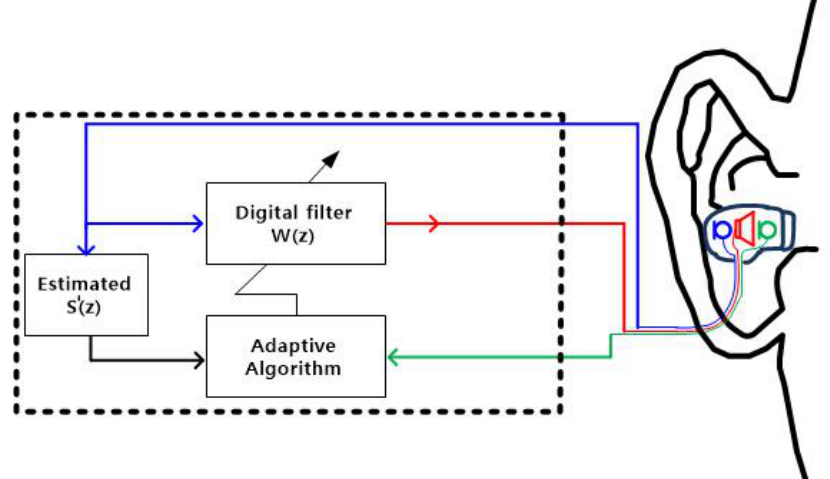
Figure 3. Conventional feedforward ANC system, using the FxLMS algorithm for an in-ear head- phone. Estimated S (cid:48) ( z ) : secondary path model. Blue: reference microphone, Green: error microphone, Red: